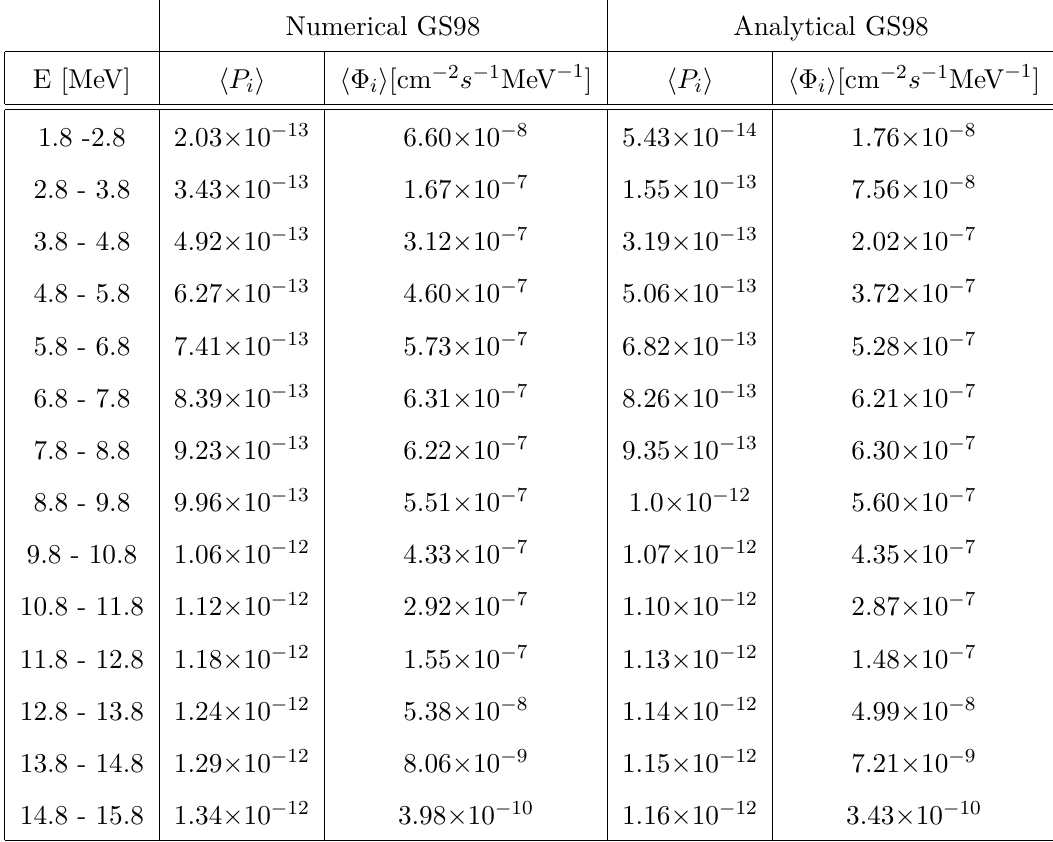
Table 2 . Same as in table 1 but for high metallicity GS98 SSM.